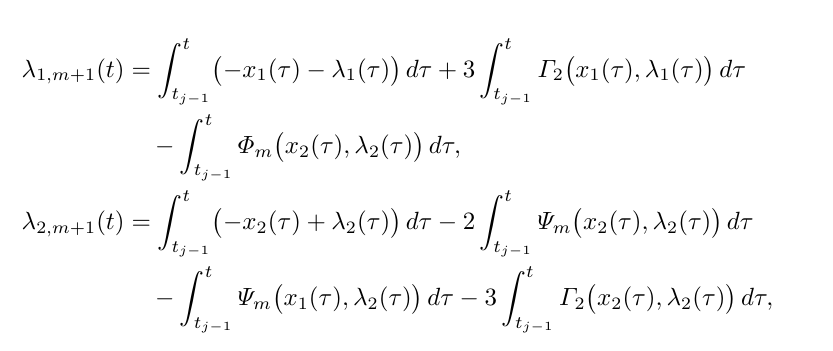
Figure 8. The optimal state function x 2 ( t ).